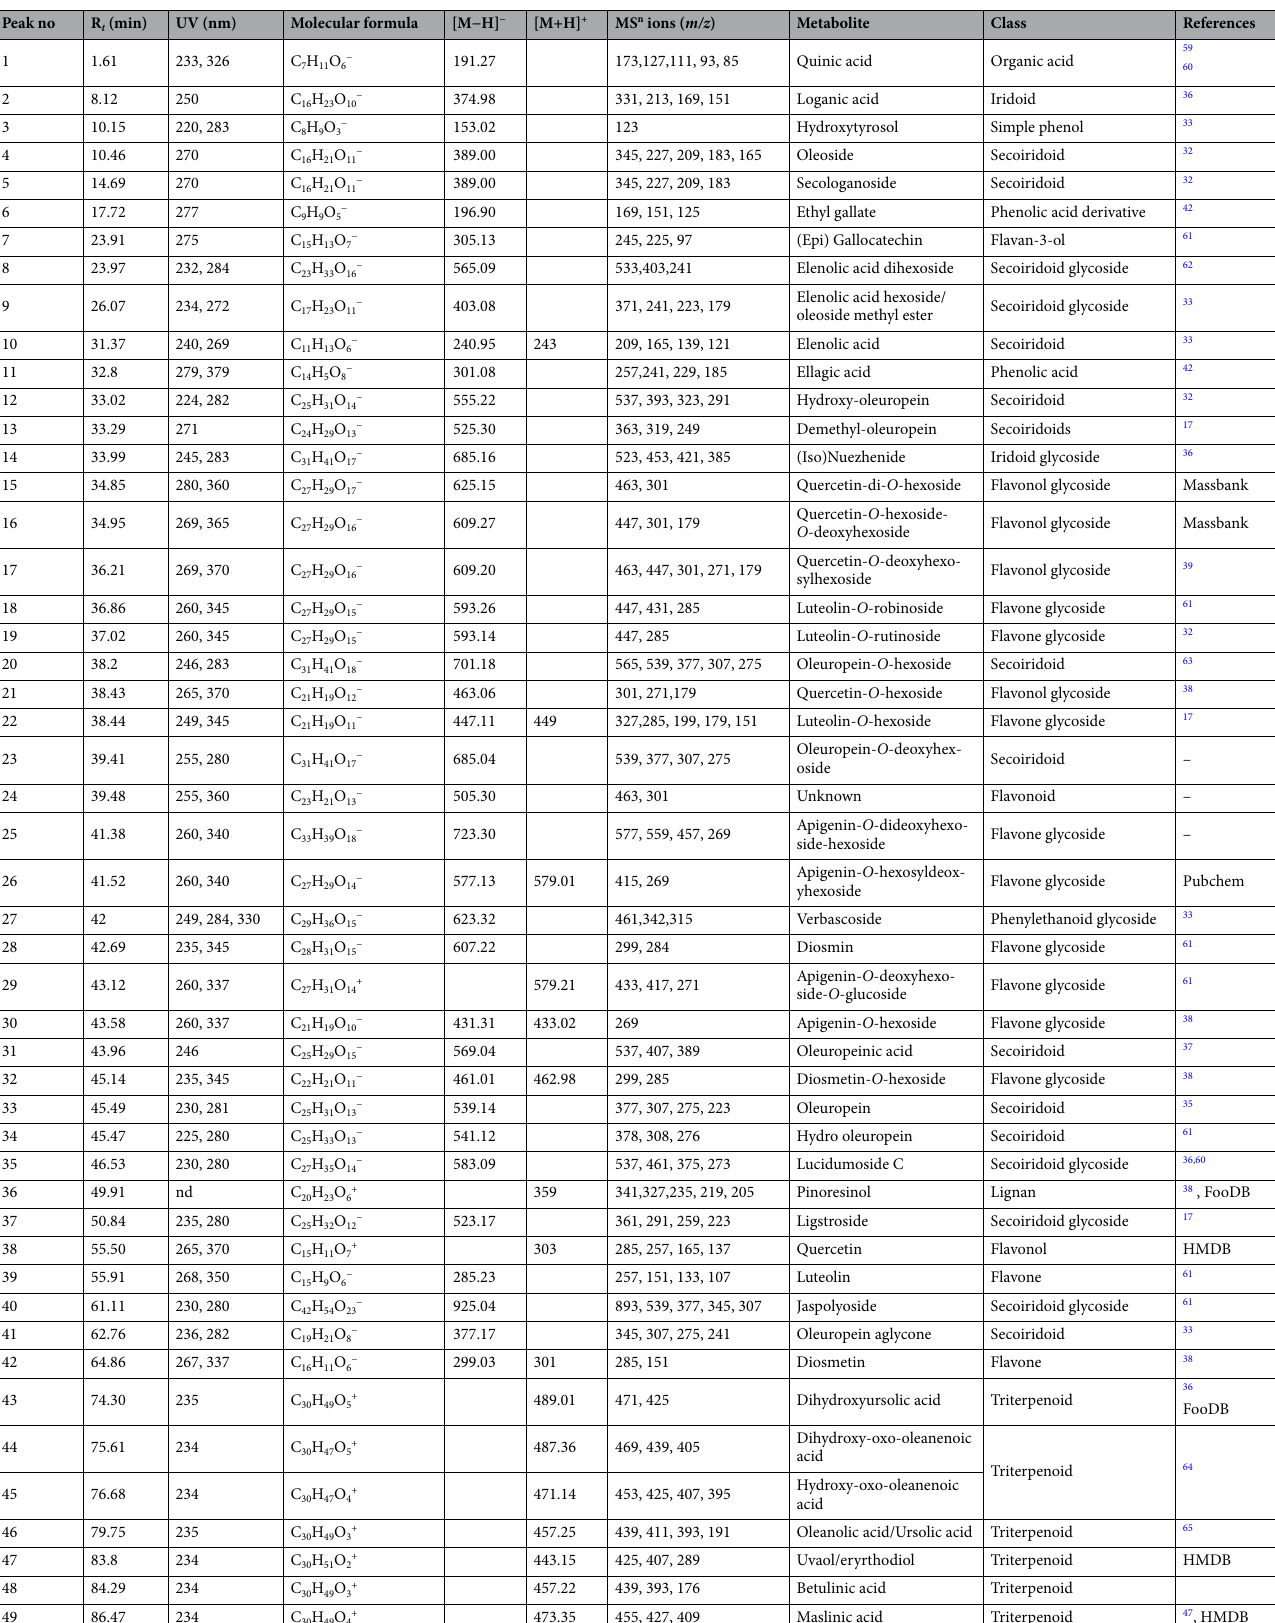
Table 1. Metabolites identified in O. europaea leaf extracts by LC/MS in both positive and negative